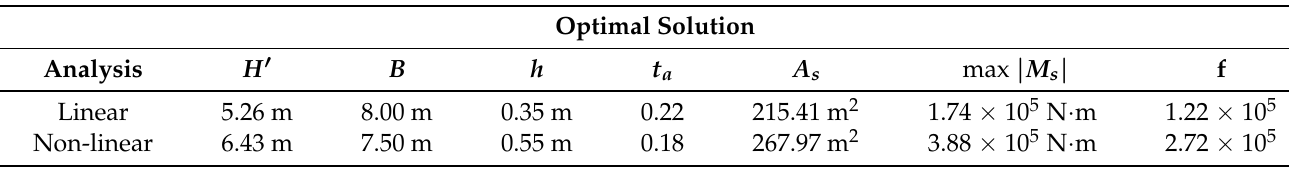
Table 5. Arch shapes comparative for optimal solutions found by the CRO-SL in the linear and the nonlinear cases in which the height B is fixed.